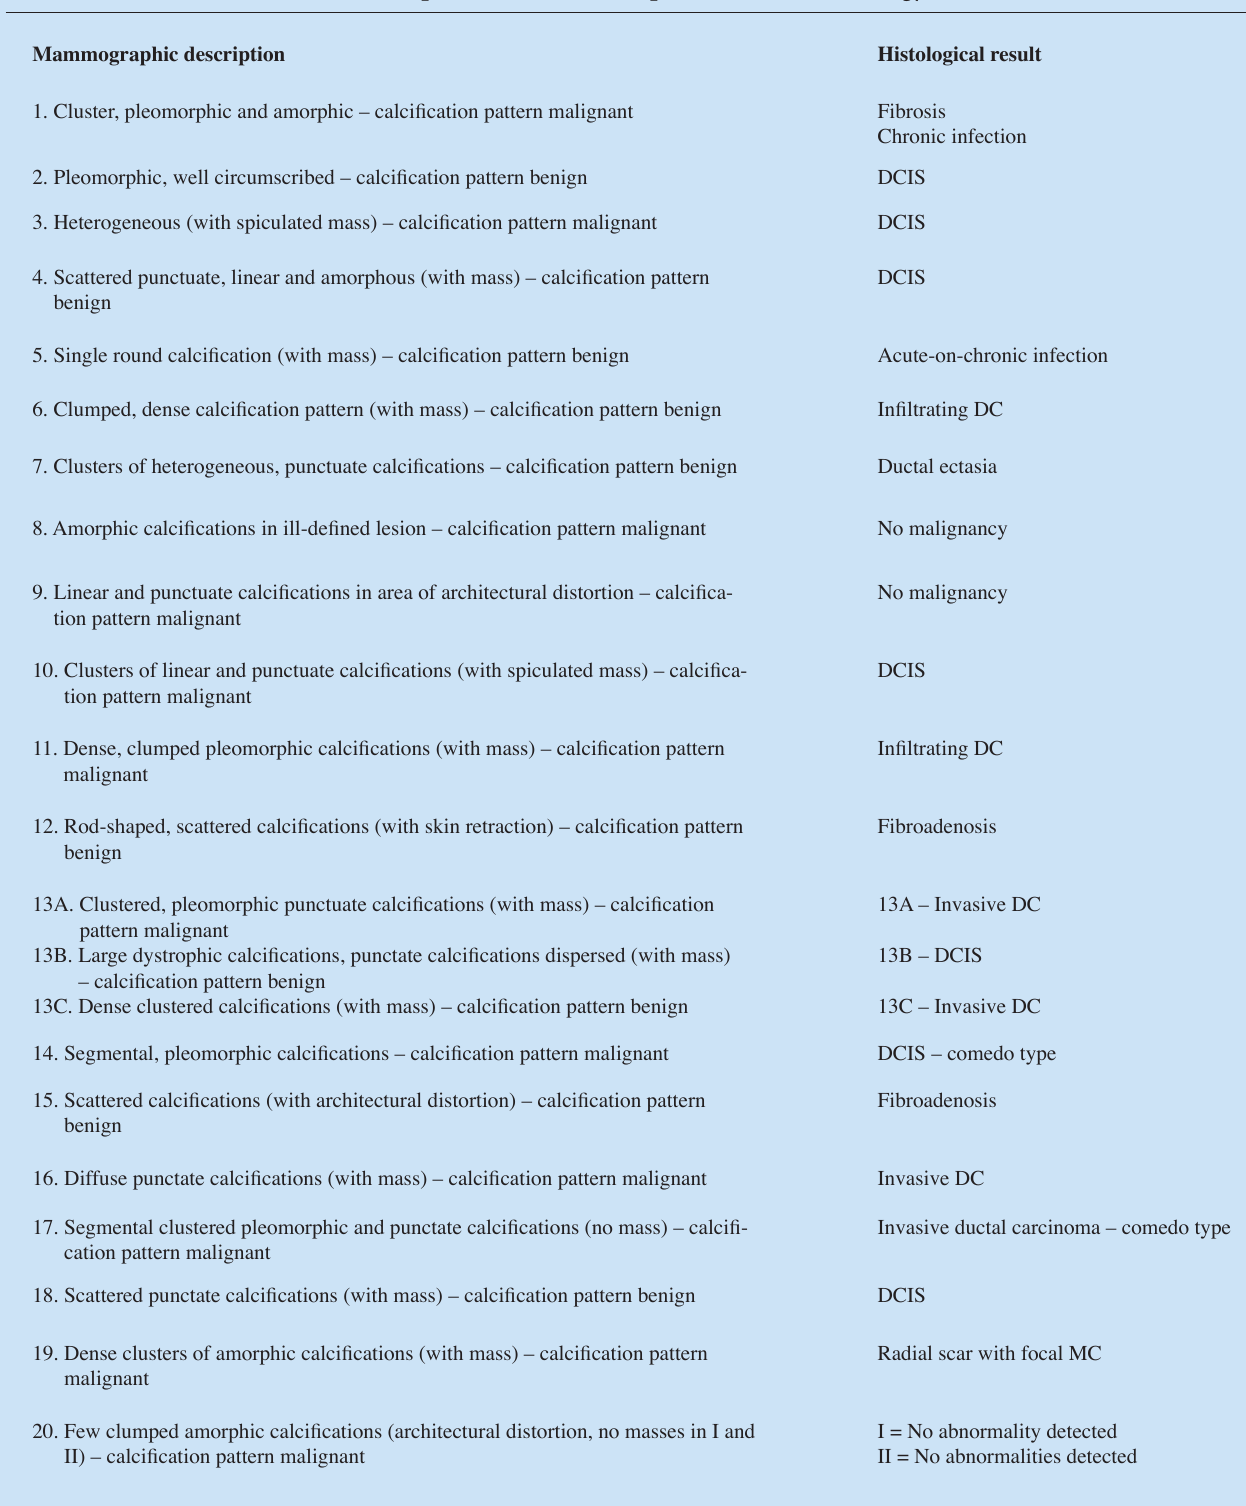
Table III. Comparison of calcification patterns with final histology